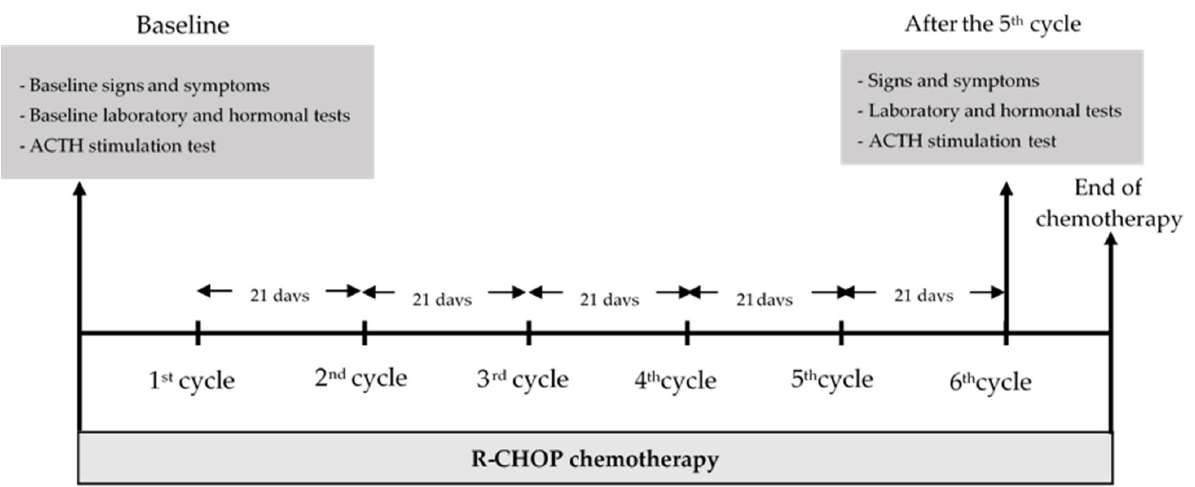
Figure 1. Diagram of the